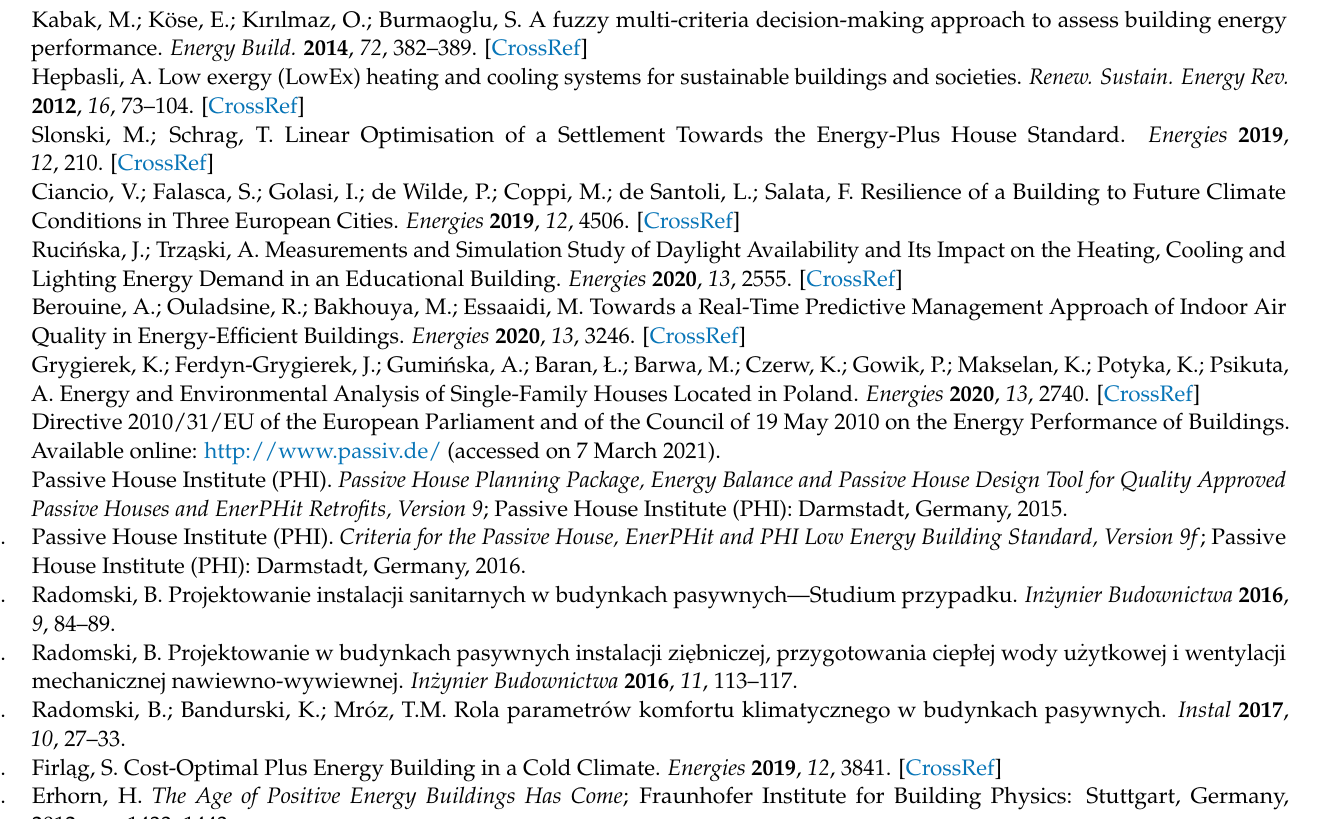
Table S3: Expert questionnaire—matrices in accordance with the DEMATEL method. Table S4: Distribution of the frequency of evaluation marks given by individual decisionmakers, the geometric mean, the median, the modal value, and the consistency index. Table S5: Questionnaire of the decision-maker’s preferences—Pairwise comparison matrices for all